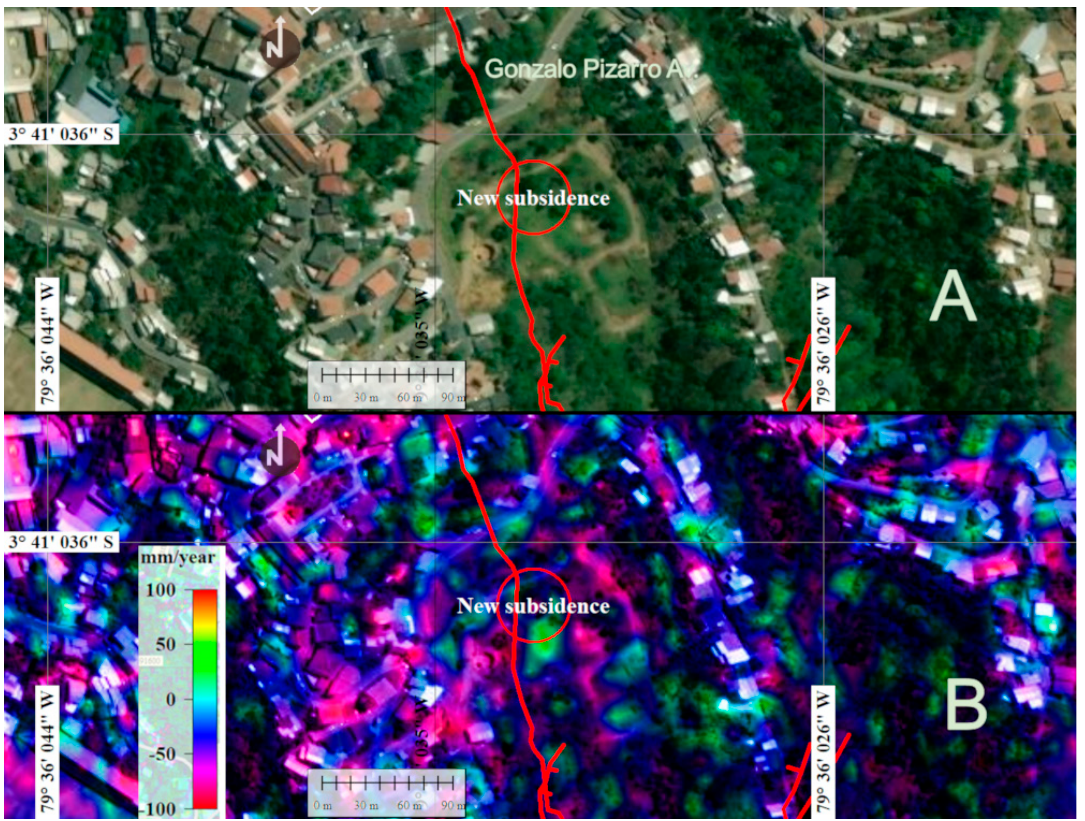
Figure 10. ( A ) Sites of new subsidence in Gonzalo Pizarro Street in August–September 2019. ( B ) The intense blue represents a range of high subsidence.